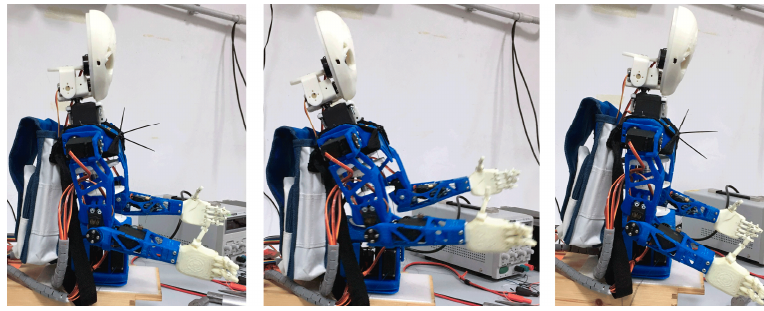
Figure 5. A snapshot of the torso while bending with a payload of 1.150 kg on the back.